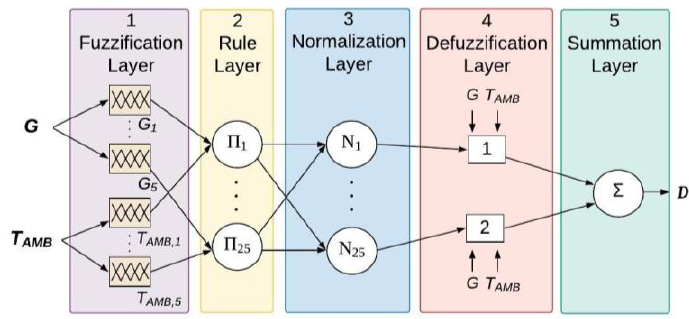
Table 5. Parameters of the fuzzy controller with the input variables G and T AMB .